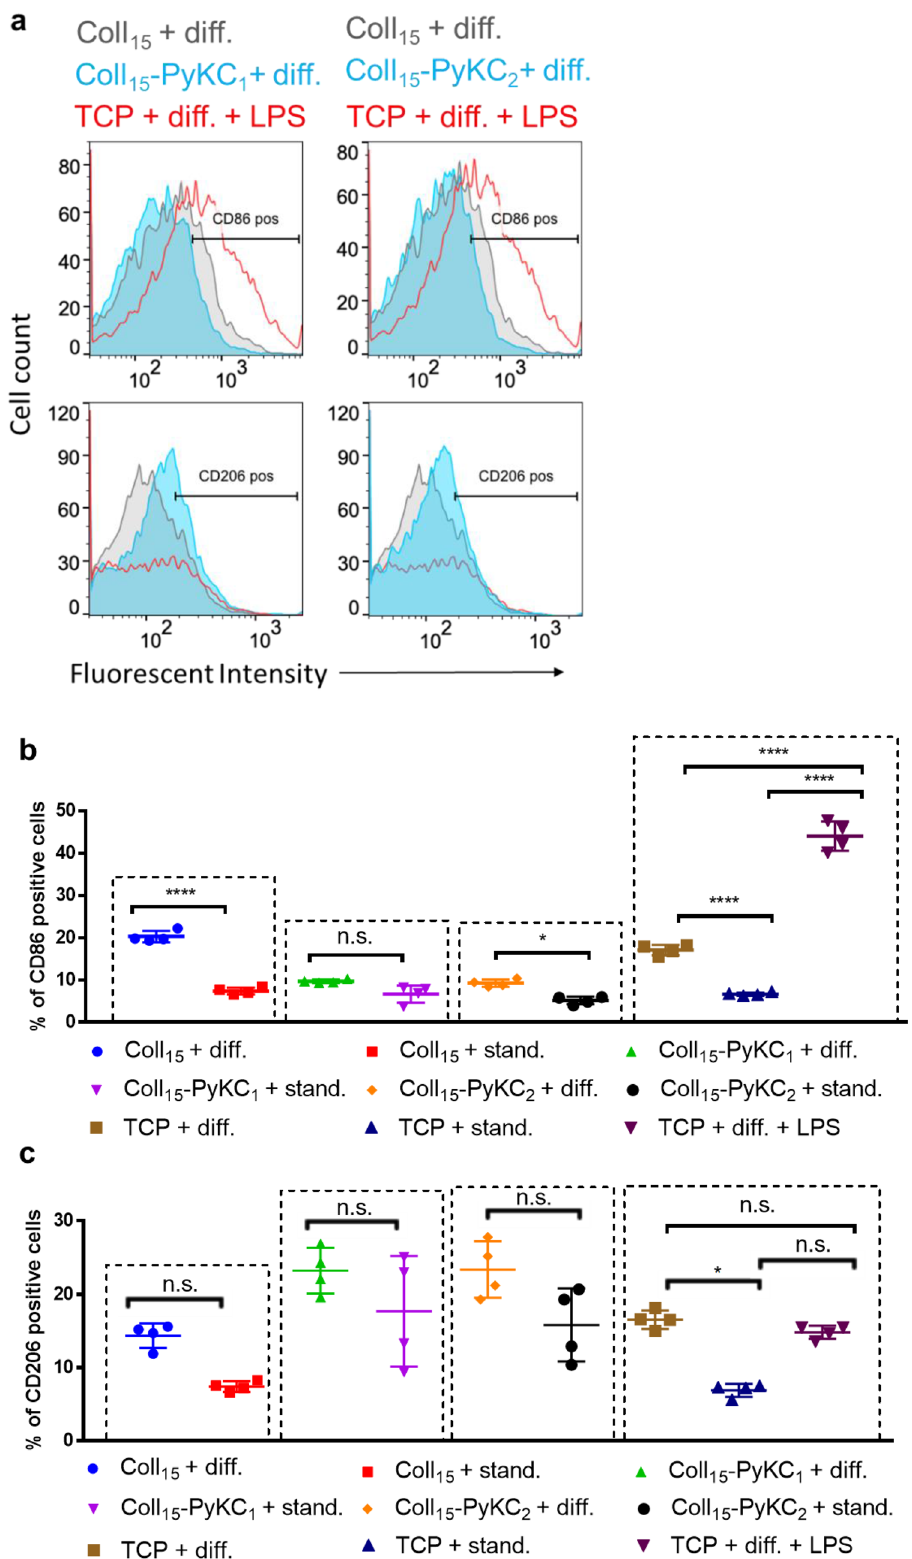
Figure 6. Human monocyte THP-1 cell differentiated to dendritic cells when cultured on different hydrogels. THP-1 cells were cultured with standard media (stand.) or differentiation media (diff.). ( a ) At day 7, the expression of CD86 (pro- inflammatory activated marker) and CD206 (inactivated marker) by cells on two PyKC collagen hydrogels cultured with differentiation media compared with control hydrogels. Cells on TCP with LPS media were used as a positive control. Complete analysis of CD86 positive cells ( b ) and CD206 positive cells ( c ) were evaluated. To simplify the figure, statistics are only shown for differences within the same hydrogel group (or TCP) when treated with different media. Quantitative results were reported as the mean ± S.D. from four independent